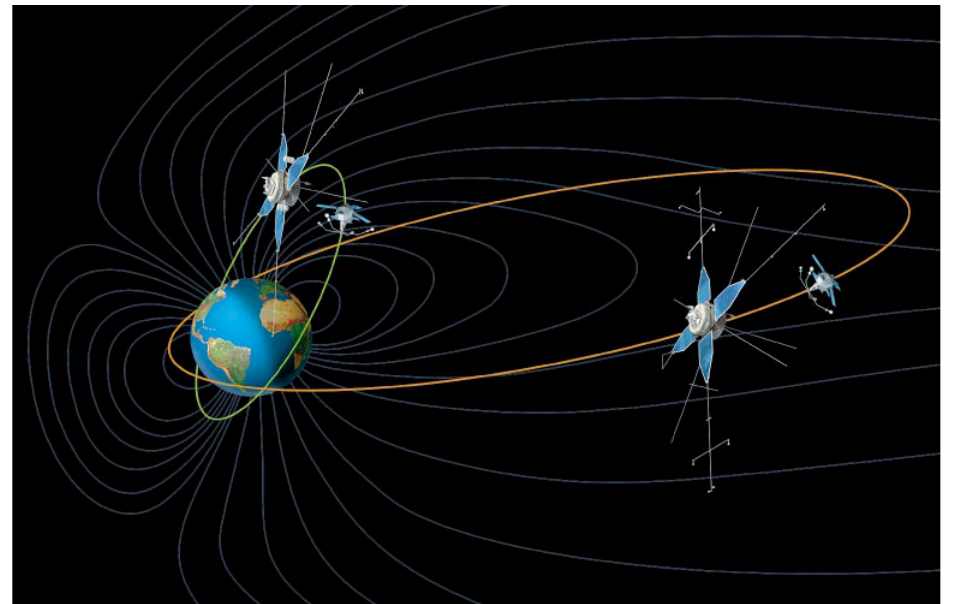
Fig. 1. Schematic view of the Interball mission in the Earth’s magnetosphere